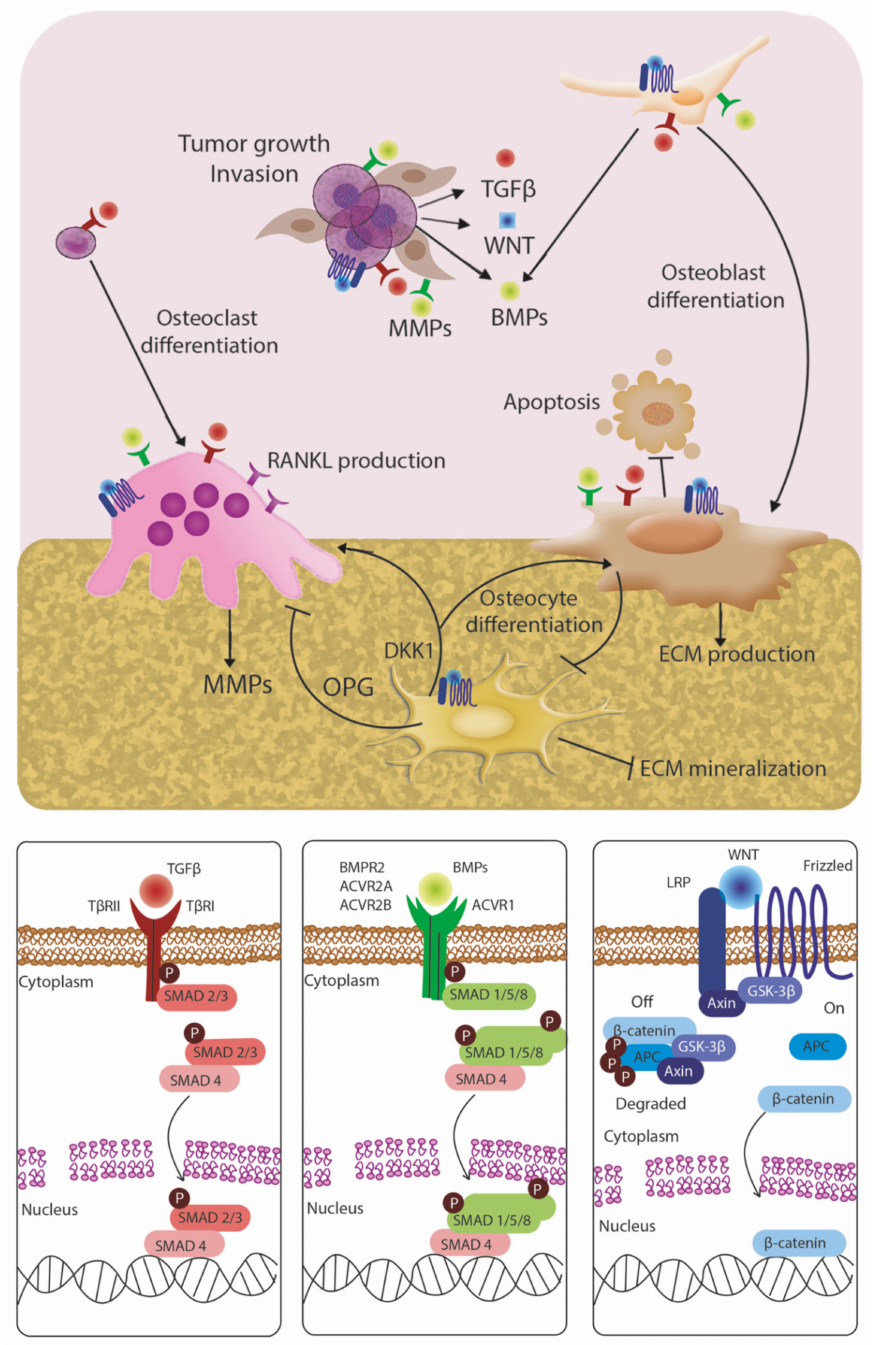
Figure 2. Paracrine signaling pathways active in the bone niche. Under nonmalignant conditions, these promote normal bone homeostasis, balancing bone deposition/mineralization and breakdown. TGF-beta, BMP, and Wnt signaling pathways are highlighted as key mediators of paracrine signaling between bone stromal cells and tumor cells. Multiple cancer cell types co-opt these pathways to promote metastasis to bone, develop treatment resistance, and enhance cancer cell survival. Multiple approaches to inhibiting these pathways include small molecule inhibitors, antibodies, and other types of